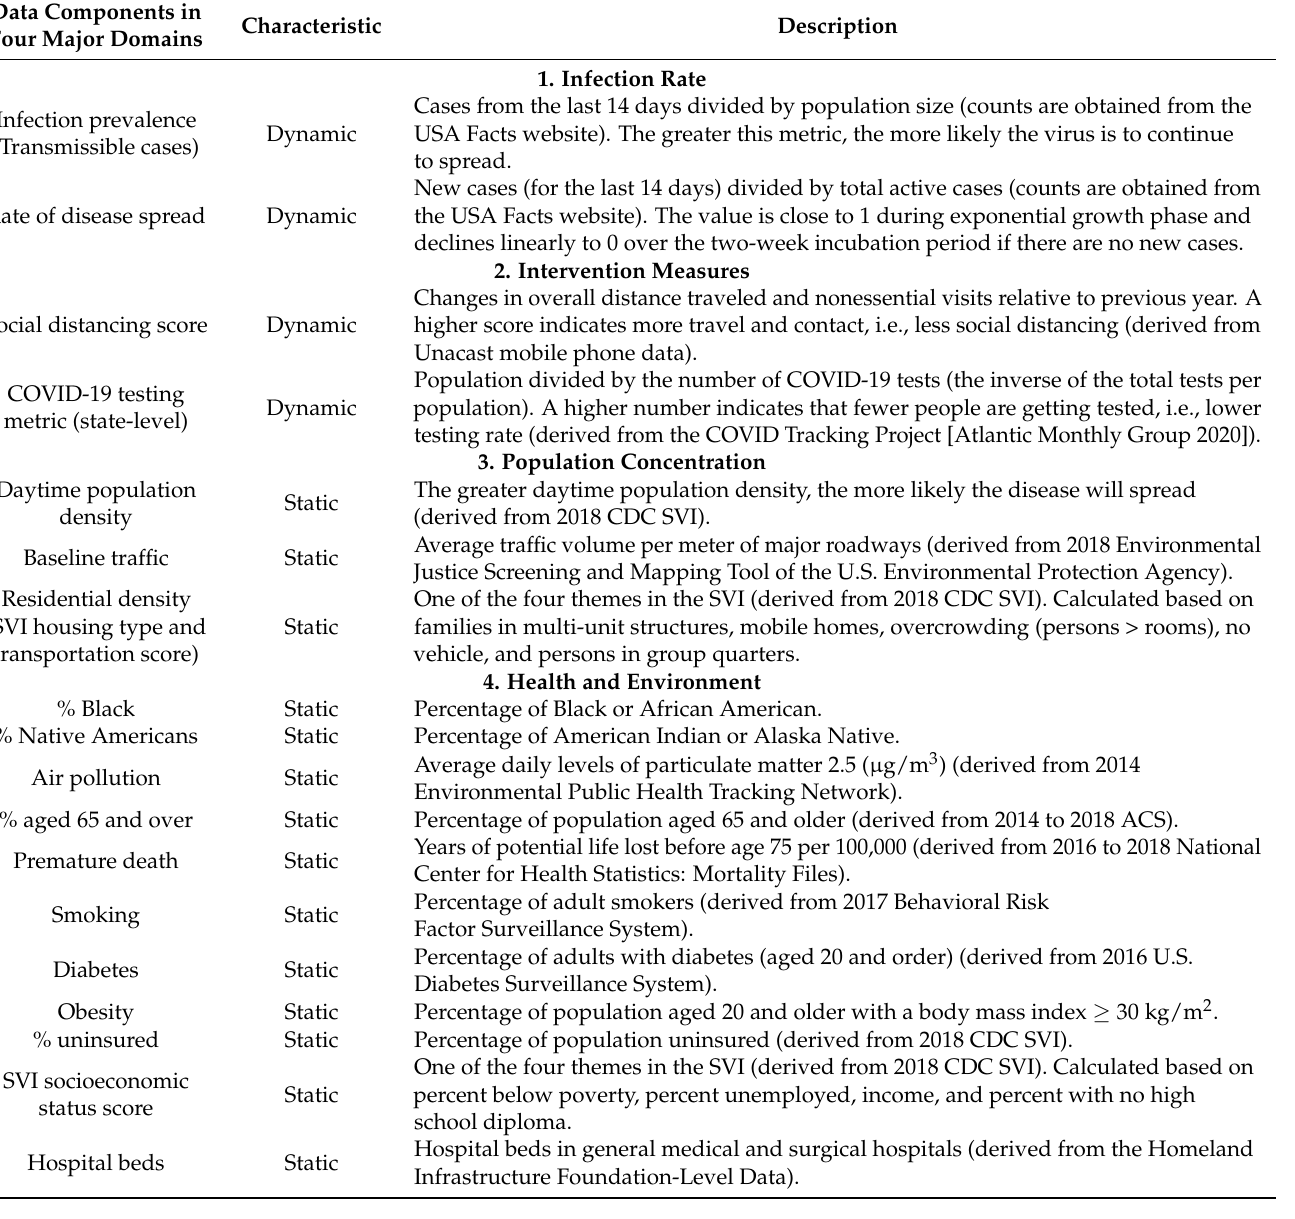
Table 1. A description of the PVI variables that comprise the four major domains